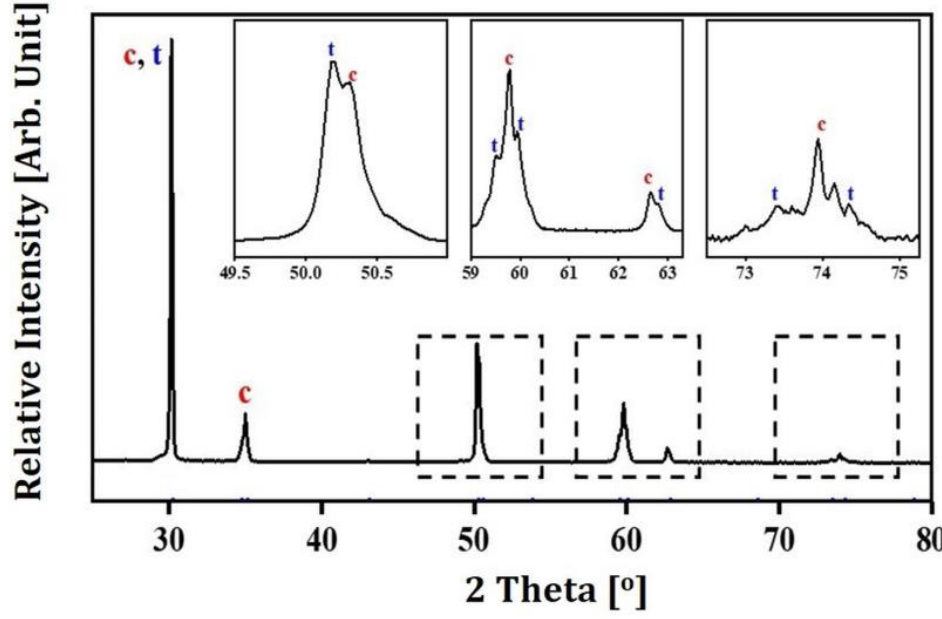
Figure 13. Representative XRD pattern of a 5Y-PSZ specimen sintered at 1500 °C for 2 h. “t” and “c” indicate tetragonal and cubic phases, respectively.